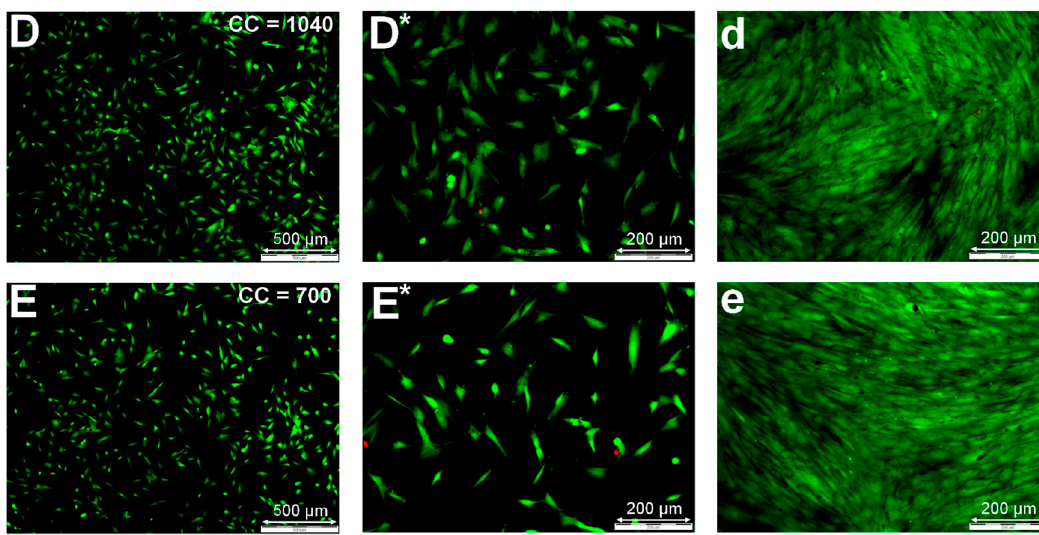
Figure 5. Life/dead fluorescent microscopic images for the different optimized plasma treatments 1 ( A – E / A* – E* ) and 7 ( a – e ) days after HFF cell seeding. A / A* / a = untreated samples; B / B* / b = He plasma-treated (22.6 J/cm 2 ); C / C* / c = Ar plasma-treated (11.3 J/cm 2 ); D / D* / d = N 2 plasma-treated (45.2 J/cm 2 ); E / E* / e = Air plasma-treated (45.2 J/cm 2 ). Cell count (CC) data given in 5 A – E were calculated from five independent images and averaged. Standard deviations were less than 10% for all conditions.